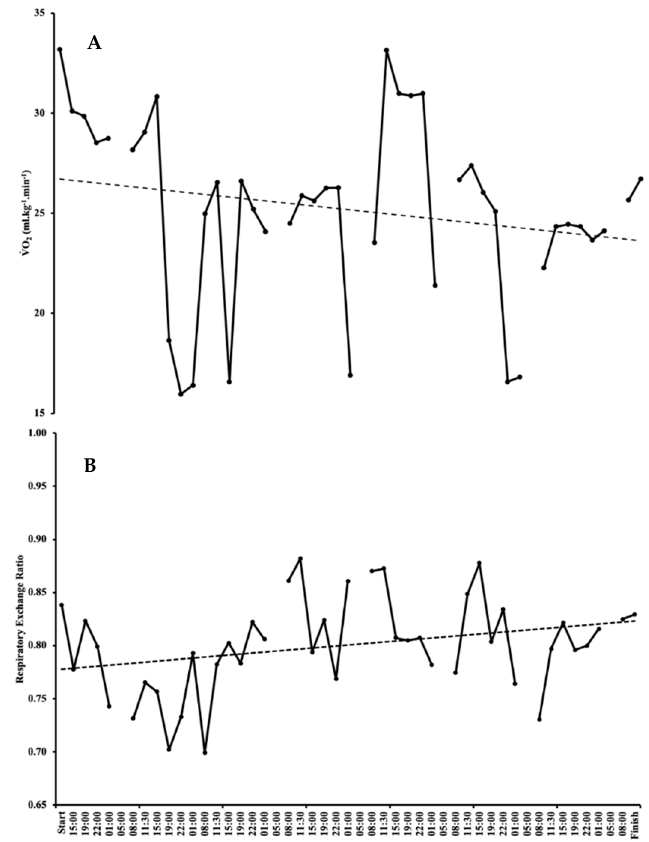
Figure 1. Perturbations in VO 2 ( A ) and RER ( B ) during the world record attempt, with accompanying trend lines. Please note missing data are from sleep periods 1–5 a.m.